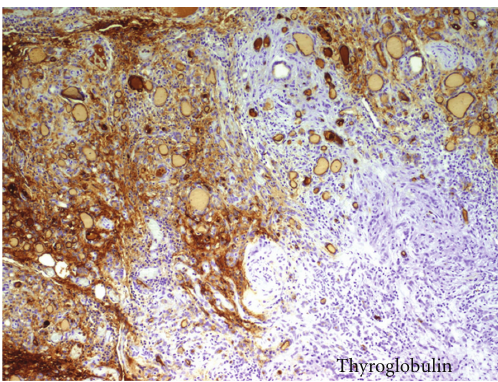
Figure 3: CD1a-positive histiocytes. (Immunohistochemical strep- tavidin-biotin Technique.